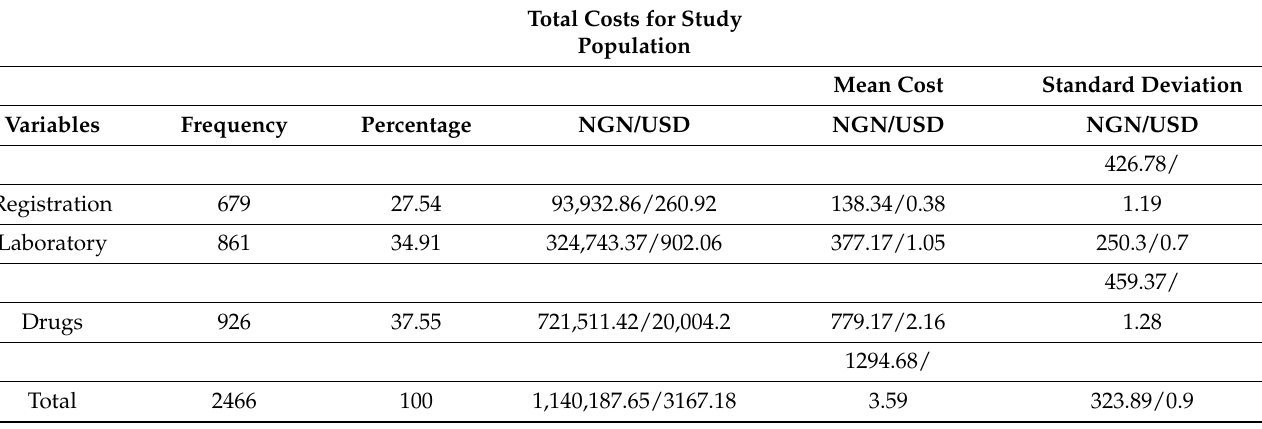
Table 2. Average direct medical costs per case of uncomplicated malaria in Plateau State (in Naira (NGN) (Nigeria currency/USD) ( N = 956). Total Costs for